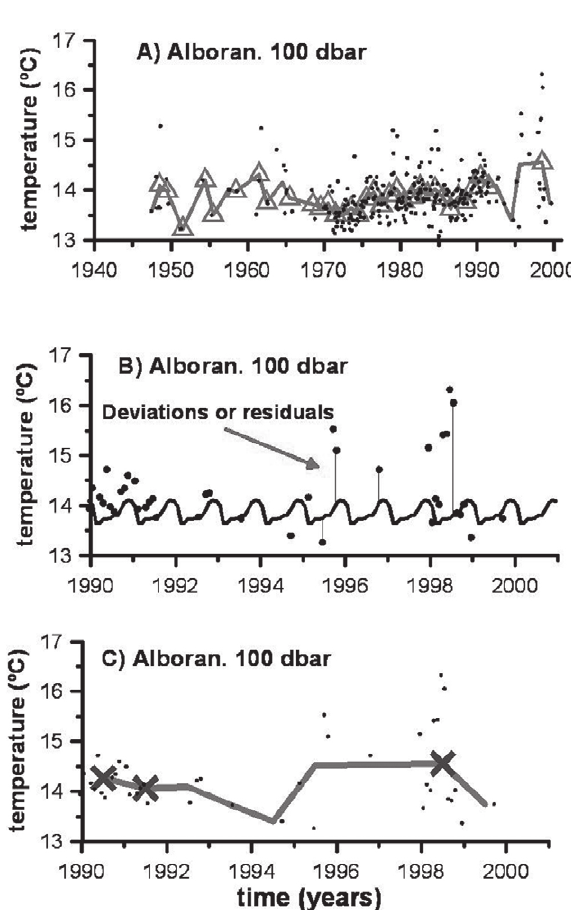
Fig . 3. – Figure 3a illustrates the large noise variance in monthly time series, especially in the upper layers (black dots). The grey line is the time series when the annual seasonal cycle has been filtered out using yearly averages, and open grey triangles show the yearly averaged time series when a restriction is imposed, in this case that valid years should contain data for at least the four seasons of the year. Figure 3b is an example of extraction of the seasonal clima- tological cycle. Figure 3c is a zoom of Figure 3a and shows the data point reduction when some restrictions are applied to the data